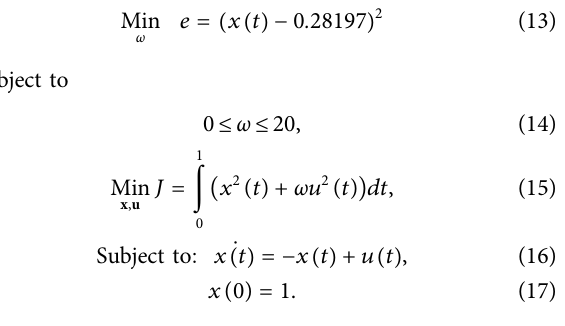
Frontiers in Bioengineering and Biotechnology |